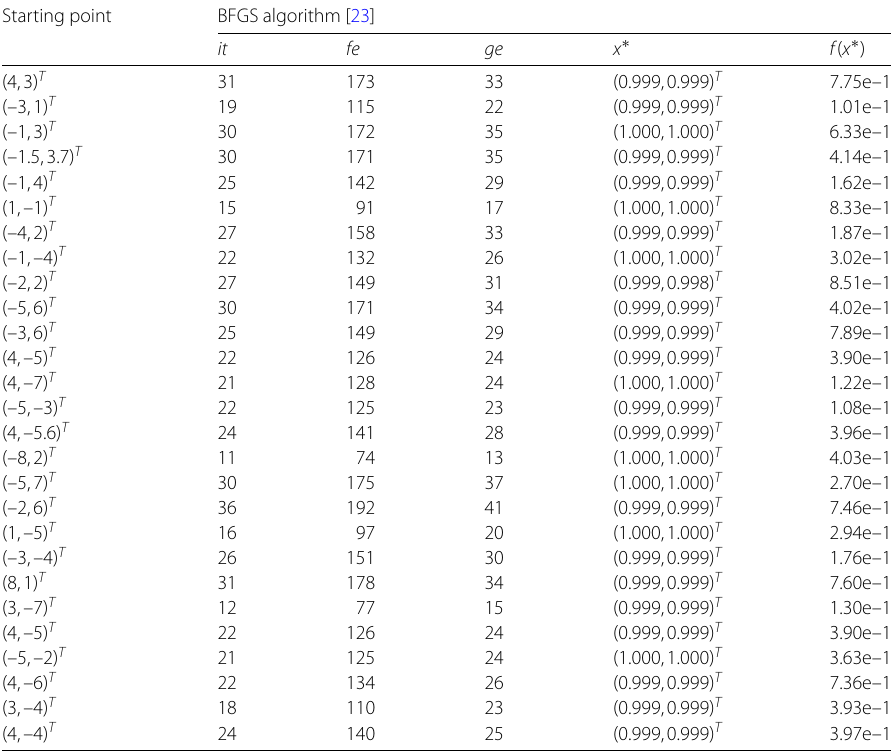
Table 4 Numerical results of Example